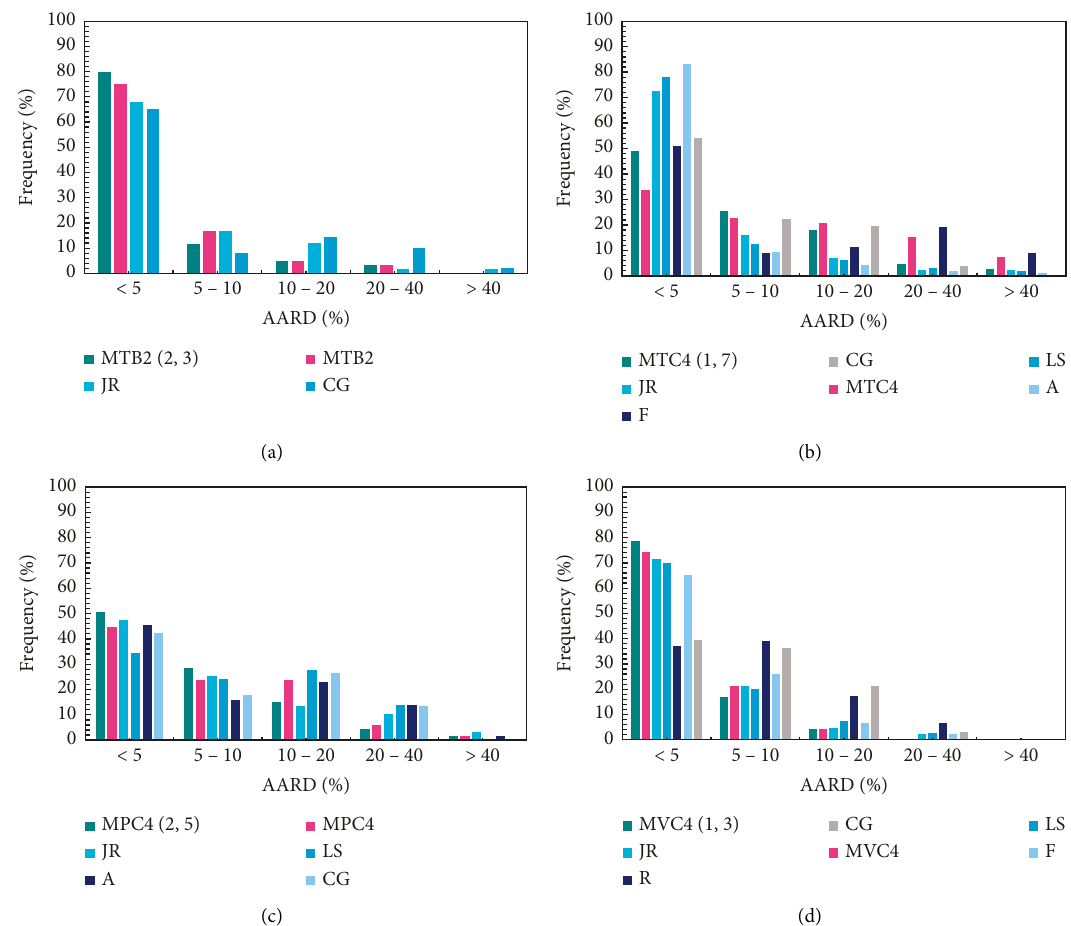
Figure 10: Distribution of AARD for the calculation of normal boiling point, critical temperature, critical pressure, and critical volume of pure compounds using first-order GCMs, and ANN. (a) Normal boiling point, (b) critical temperature, (c) critical pressure, and (d) critical